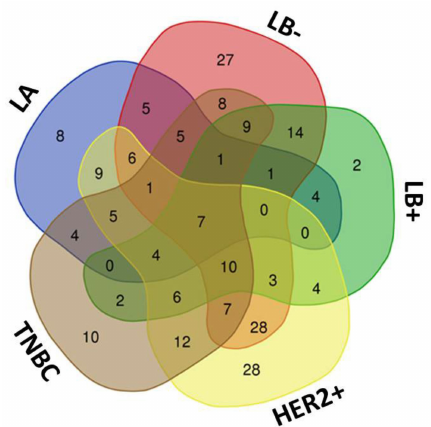
Figure 4. Venn diagram showing the number of shared and specific (or unique) deregulated proteins identified in the PCs formed after the interaction of AuNPs (12.96 ± 0.72 nm) with serum samples of the di ff erent BC subtypes (LA, LB-, LB + , HER2 + and